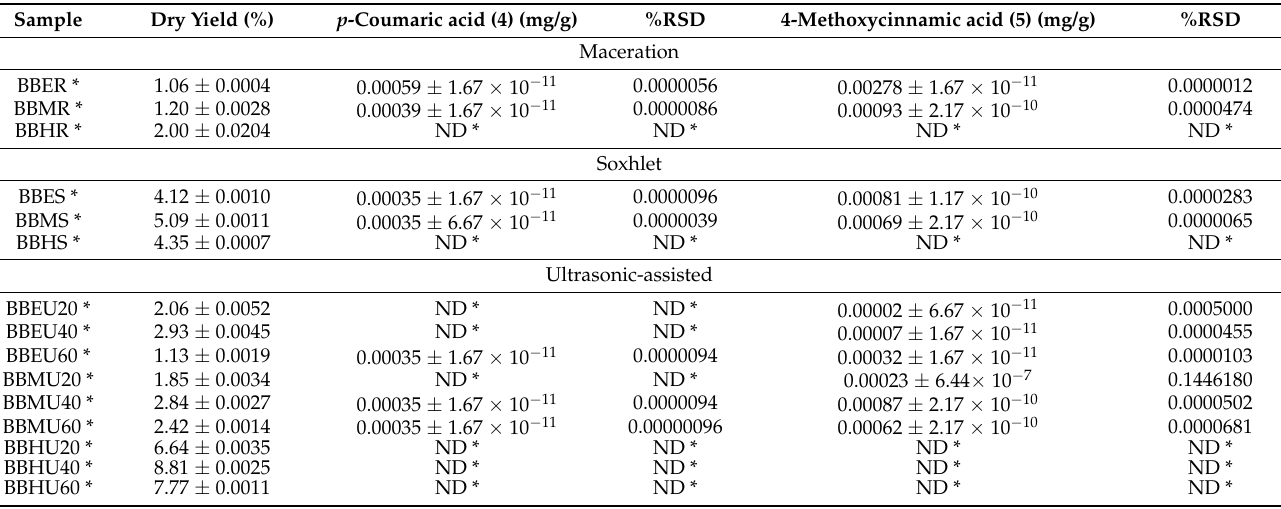
Table 1. Yield percentage of Bambusa beecheyana extracts.